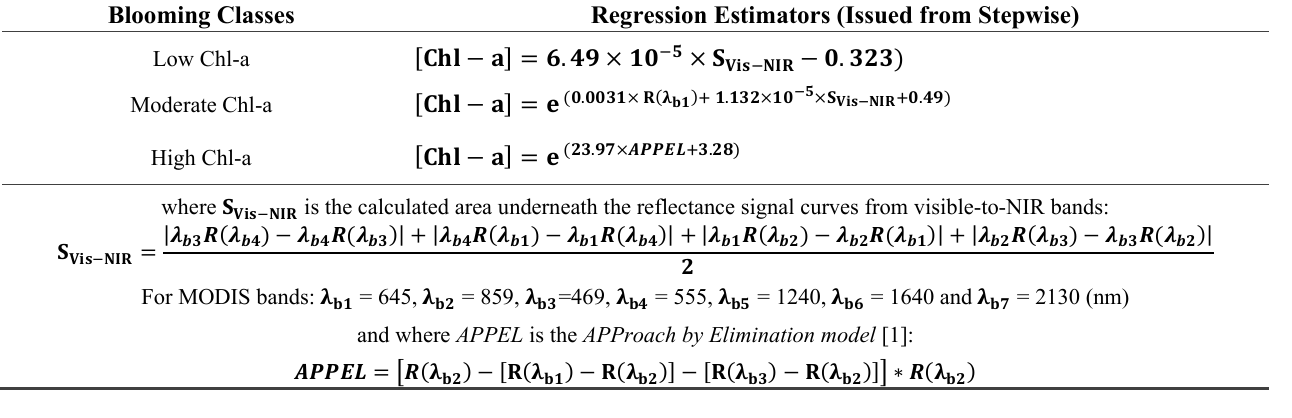
Table 2. Equations of the three calibrated models (or estimators ) using a multivariate regression to estimate Chl-a